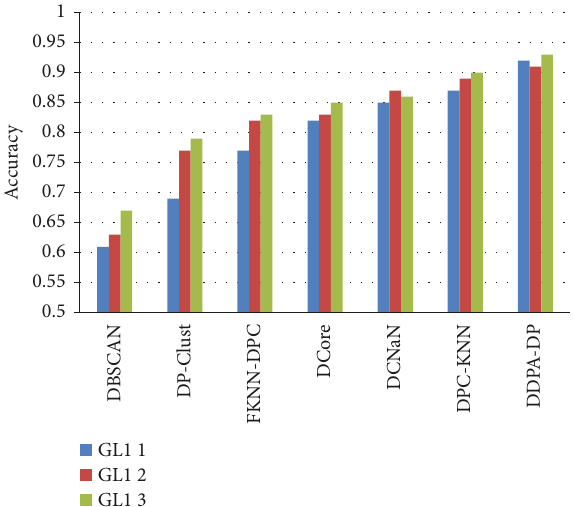
Figure 19: The simulation results in DIM.